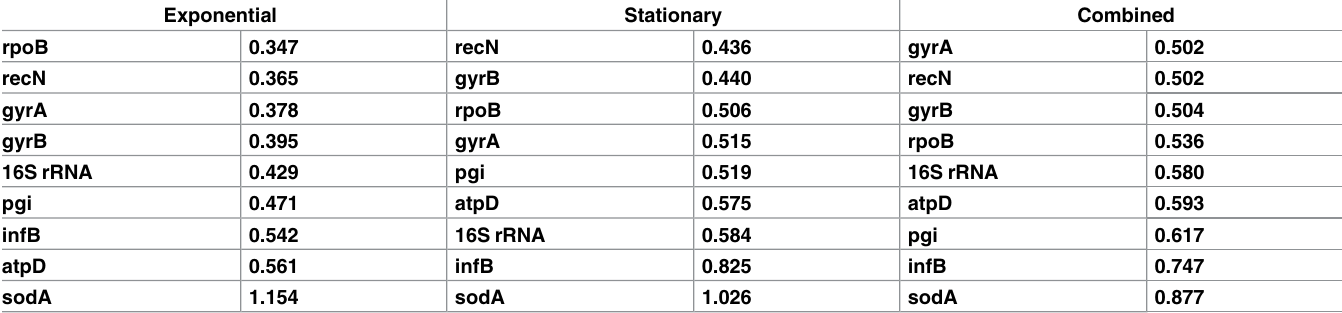
Table 4. Gene expressionstability rankings for different growth phase in A . paragallinarum serovarC analyzed by geNorm. Exponential